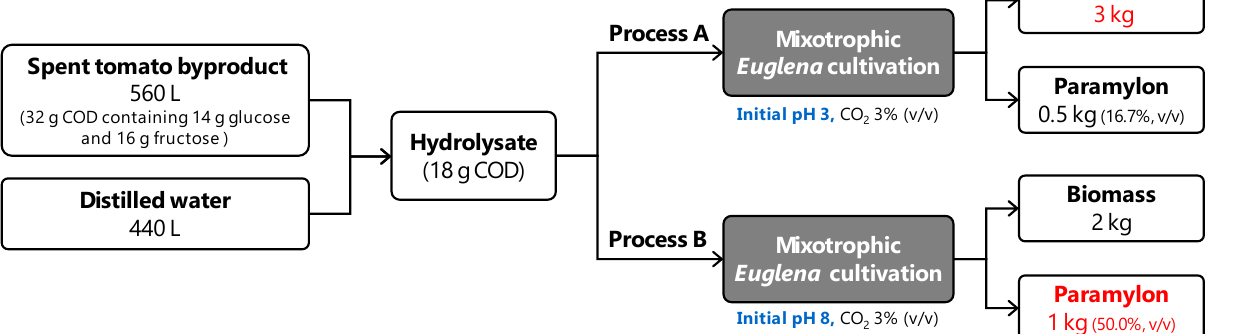
Figure 5. Biomass and paramylon production using STB at initial pH 3 and 8.